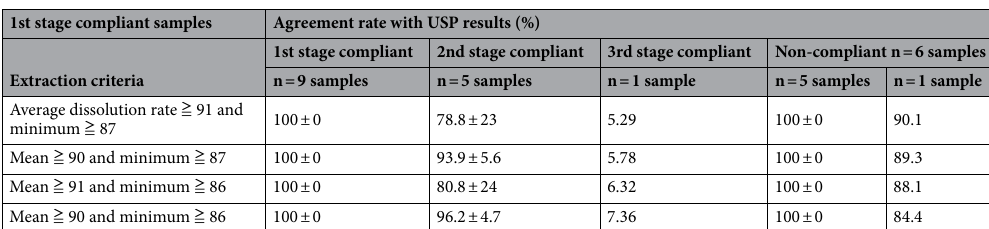
Table 2. Agreement rate with USP for n = 21 samples of metronidazole judged from average dissolution rate and minimum dissolution rate of n = 3 units.